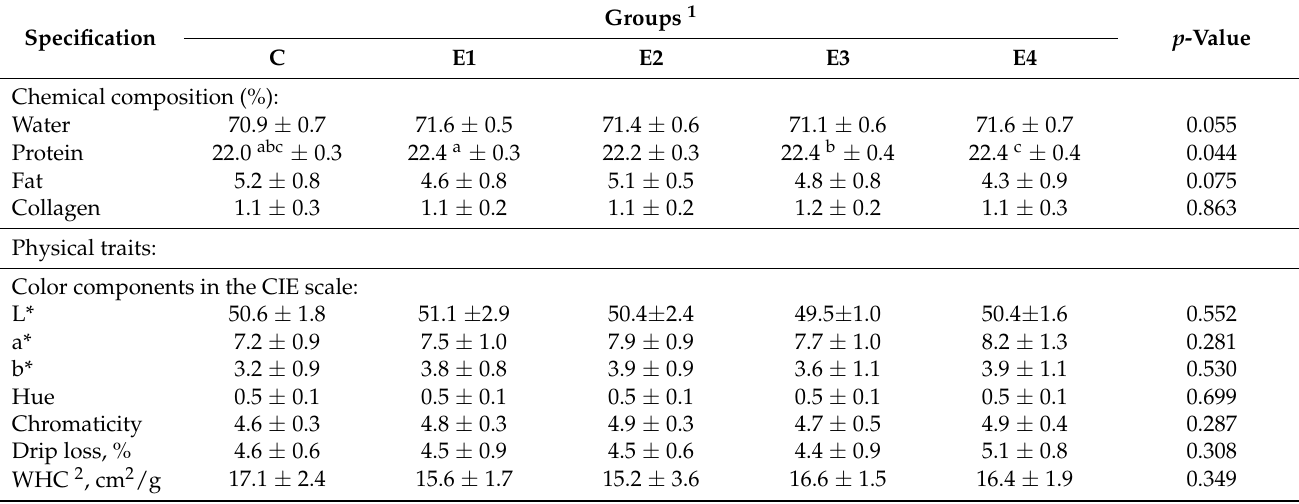
Table 6. Quality of meat from Musculus longissimus lumborum of fatteners, ( x ±